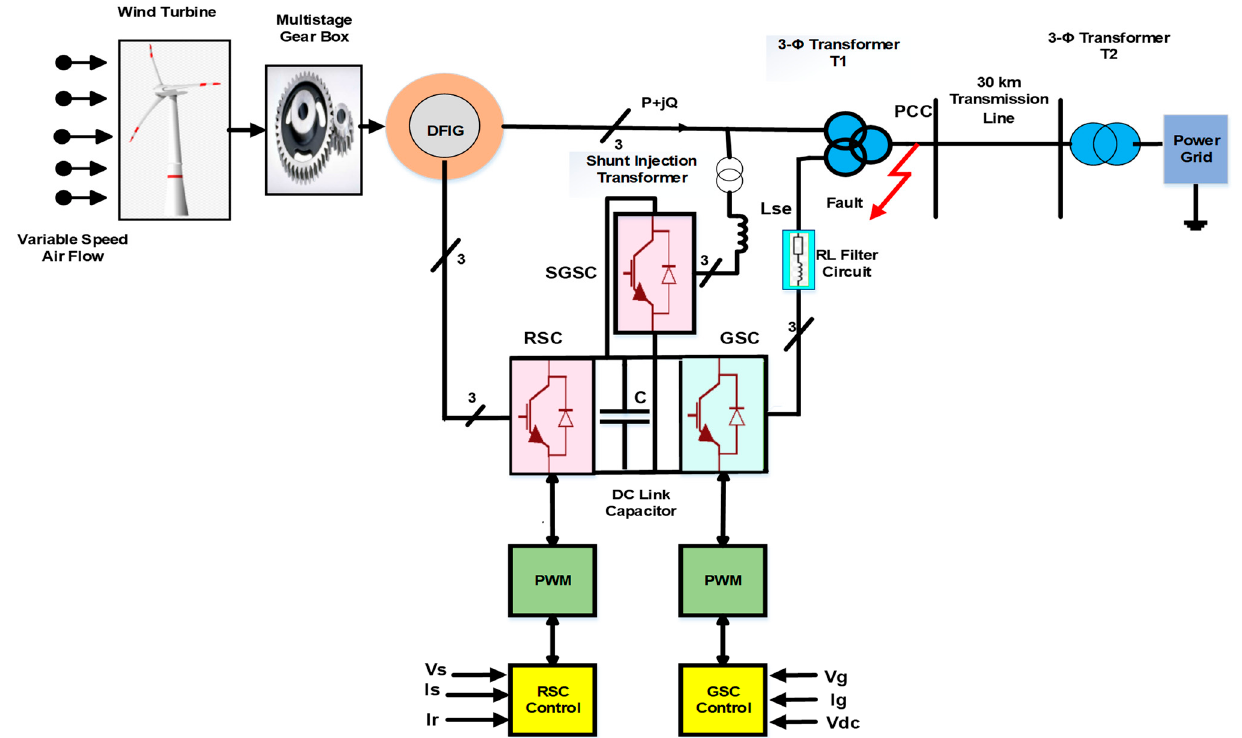
Figure 1. Simpli fi ed block diagram of grid-integrated DFIG-based WECS with auxiliary SGSC. Figure 1. Simplified block diagram of grid-integrated DFIG-based WECS with auxiliary